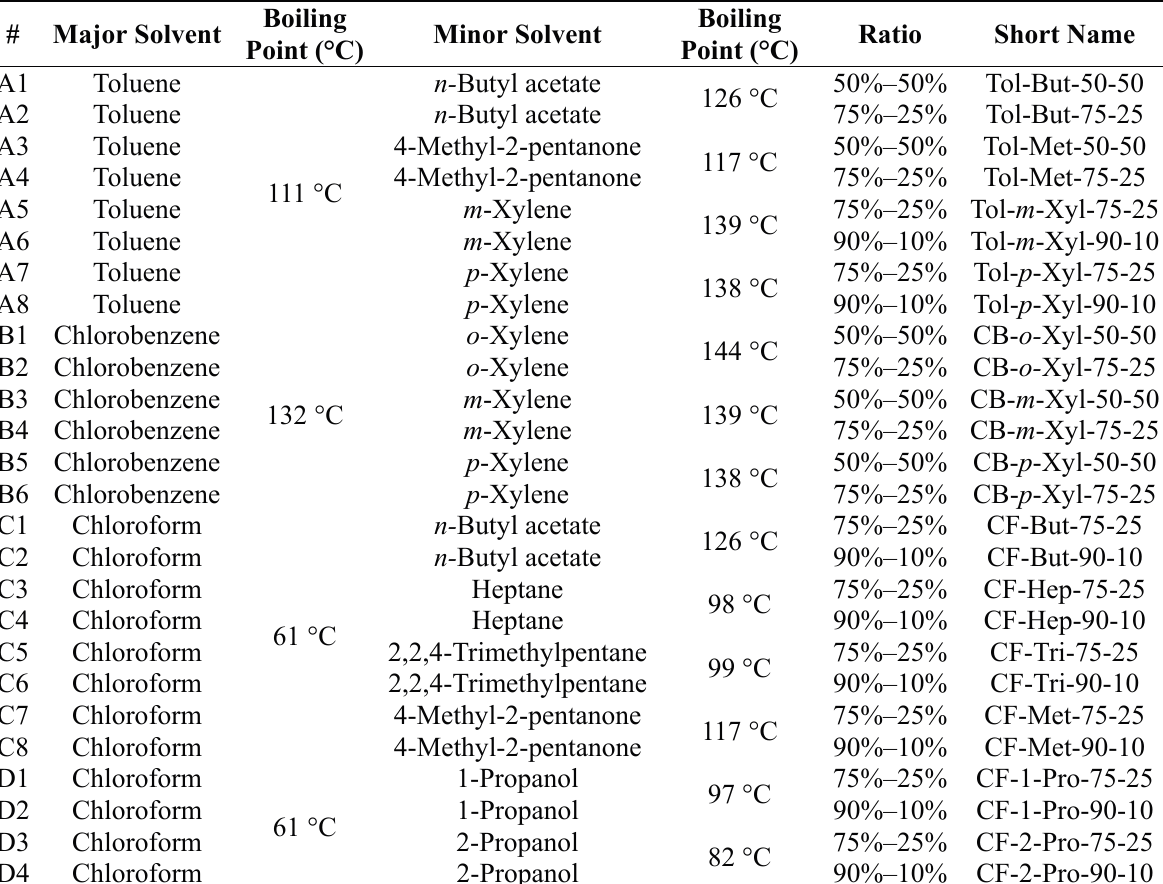
Table 1. List of the 26 different solvent